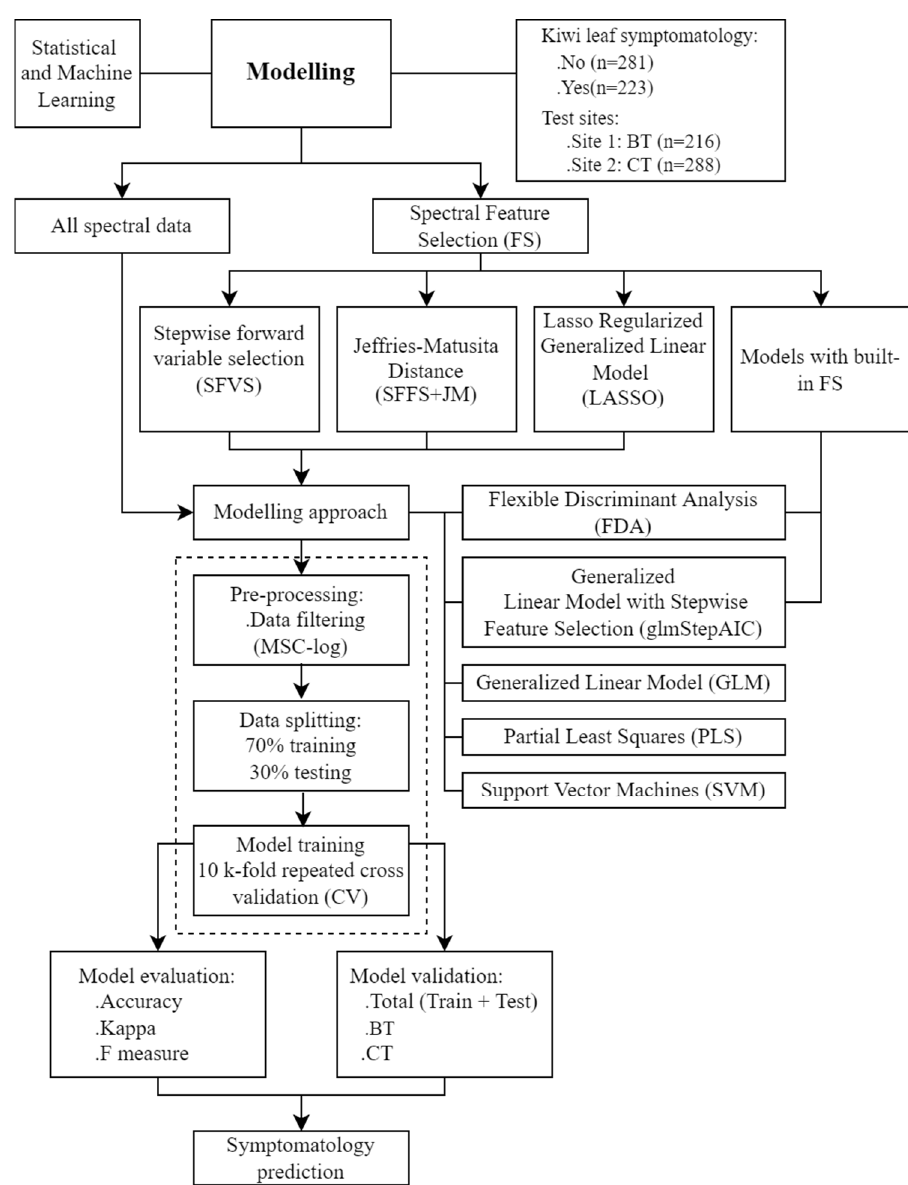
Figure 5. Conceptual diagram for the predictive modeling approaches of bacterial canker of kiwi (BCK).